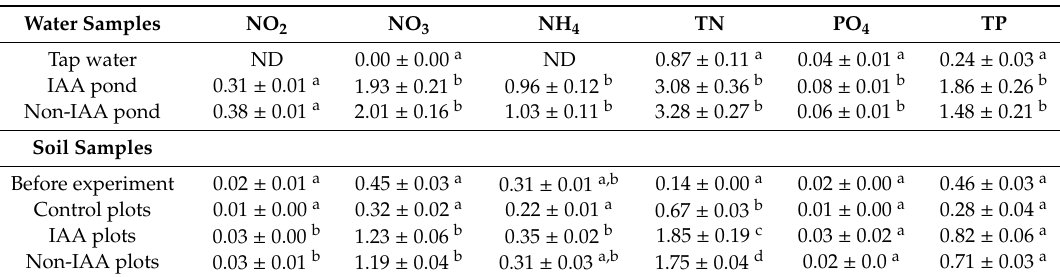
Table 6. Water and soil nutrient concentration (mg / L) in tap water and in water from IAA and non-IAA fish ponds (mean ±